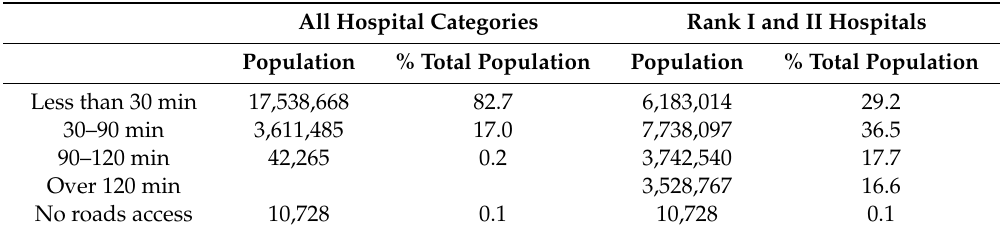
Table 2. Population access to hospitals. All Hospital